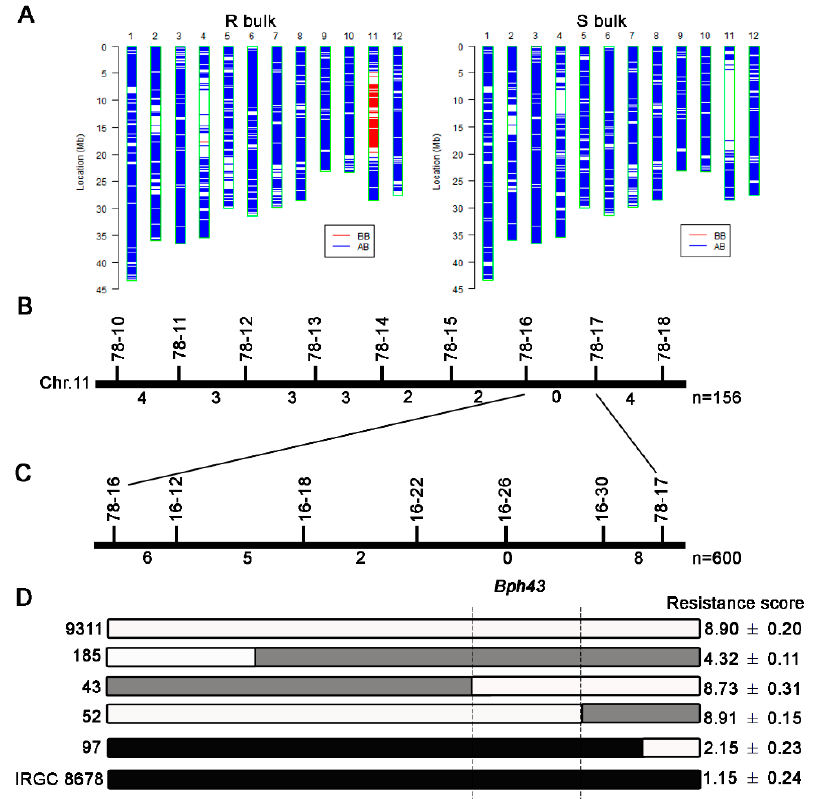
Figure 2. Molecular mapping of Bph43 . ( A ) Mapping of Bph43 on rice chromosome 11 using bulked segregant analysis (BSA)-based rice chip GSR 40K analysis. Red lines indicate the genetic background of IRGC 8678, while white ones indicate that of 9311. Blue lines indicate the heterozygous genomic fragments between IRGC 8678 and 9311. R, resistant; S, susceptible; ( B ) mapping of Bph43 on the genomic region flanked by markers 78–16 and 78–17; ( C ) physical map of marker intervals 78–16 and 78–17. The numbers below the line in ( A ) and ( B ) indicate the numbers of recombinants between adjacent markers; ( D ) graphical genotypes and resistance phenotypes of the recombinants. The black, white, and grey bars denote the genotypes of IRGC 8678 homozygotes, 9311 homozygotes, and heterozygotes, respectively.